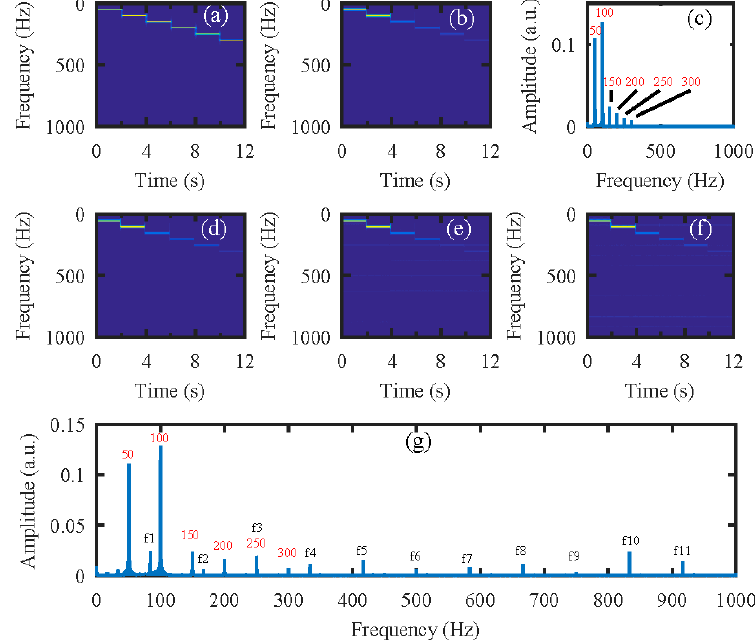
Figure 4. The simulation results for an audio signal with increasing frequencies from 50 Hz to 300 Hz with an interval of 50 Hz. Each segment lasts 2 s. ( a ) The original audio spectrogram. ( b ) The spectrogram of audio reconstructed directly from the high-speed video and ( c ) its frequency spectrum. The spectrogram of audio reconstructed from the high-speed video reconstructed using the compressive camera with ( d ) 8 × , ( e ) 16 × , and ( f ) 24 × compression. ( g ) The frequency spectrum of the signal in ( f ). The red text of 50 to 300 Hz in ( c ) and ( g ) indicate the expected signal, while f1 to f11 in ( g ) indicate the undesired harmonic noise related to the frame rate (2000/24 Hz) of the compressive